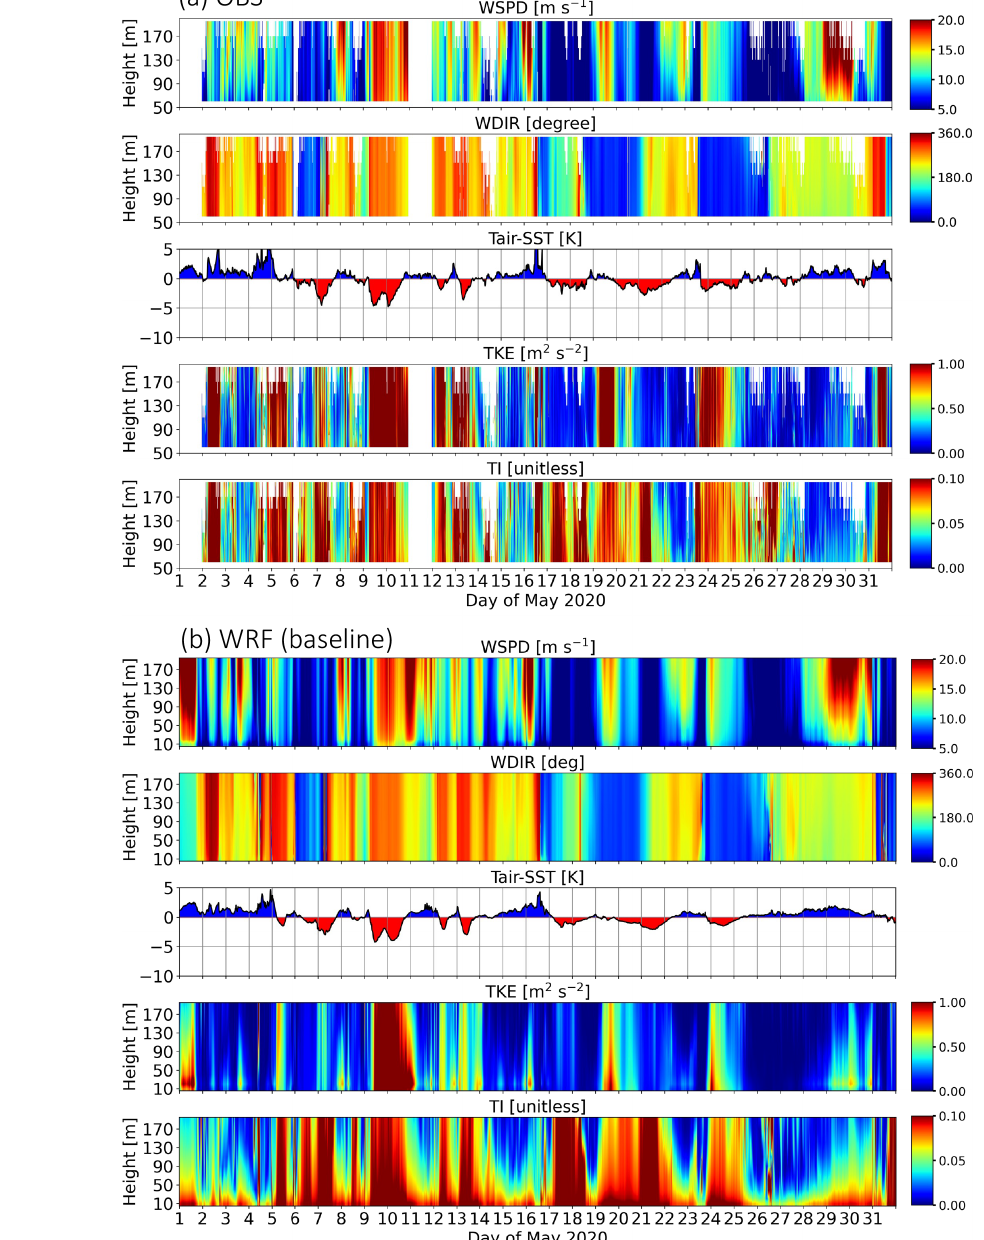
Figure 4. Similar to Fig. 3, but results for May 2020 are